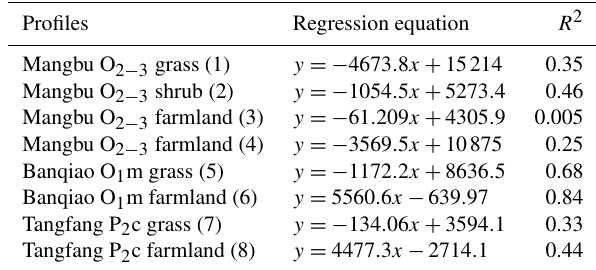
Table 3. Correlation analysis of soil CO 2 and soil organic carbon in carbonate areas of